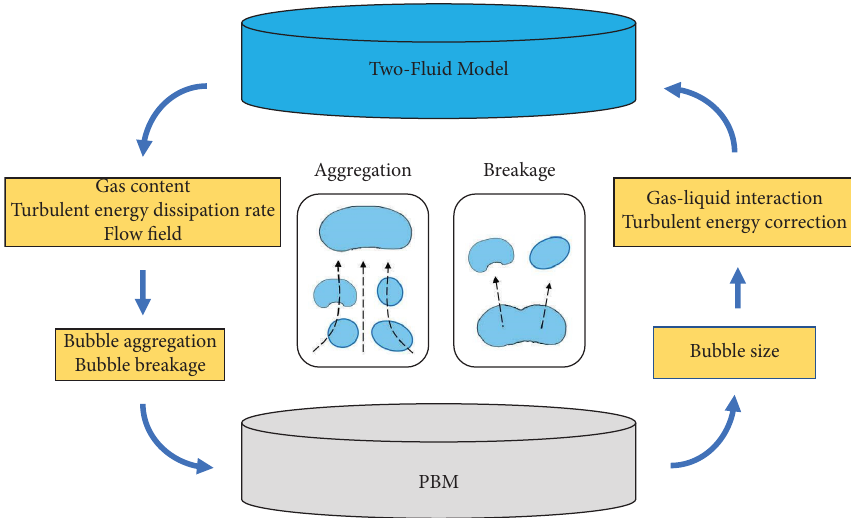
Figure 1: Diagram of the coupling